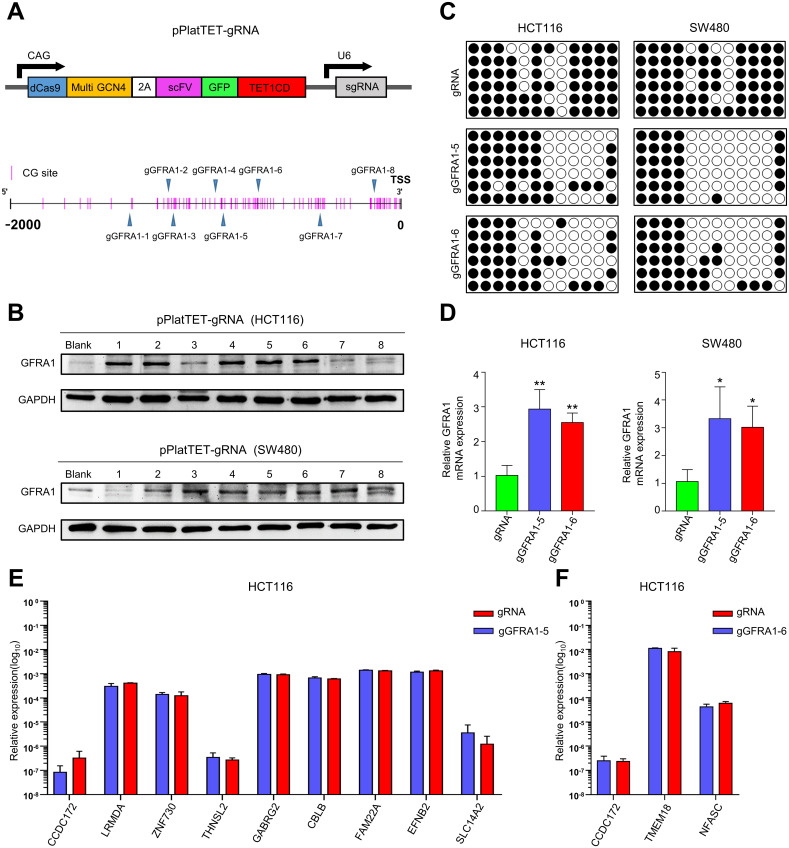
Targeted demethylation of GFRA1 by dCas9-Tet1CD and verification of off-target effect in CRC cells.A Schematic representation of dCAS9-mediated targeted demethylation plasmid and distribution of gRNA the upstream of the GFRA1 TSS. B Expression of GFRA1 after transfection of pPlatTET-gRNA plasmids constructed from different gRNAs in HCT116 and SW480 cells was detected using western blotting. C BSP-seq determination of TSS region demethylation effect of pPlatTET-gGFRA1-5 and pPlatTET-gGFRA1-6 in HCT116 and SW480 cells (methylation CpG sites are shown as black dots, unmethylation CpG sites are shown as white dots). D The mRNA levels of GFRA1 in GFRA1-targeted demethylation CRC cells detected by Real-time PCR analysis (*p < 0.05, **p < 0.01; student t-test). E-F The relative expression of genes at gGFRA1-5 and gGFRA1-6 off-target sites in HCT116 cells (Student’s t-test). Data are mean ± SD.